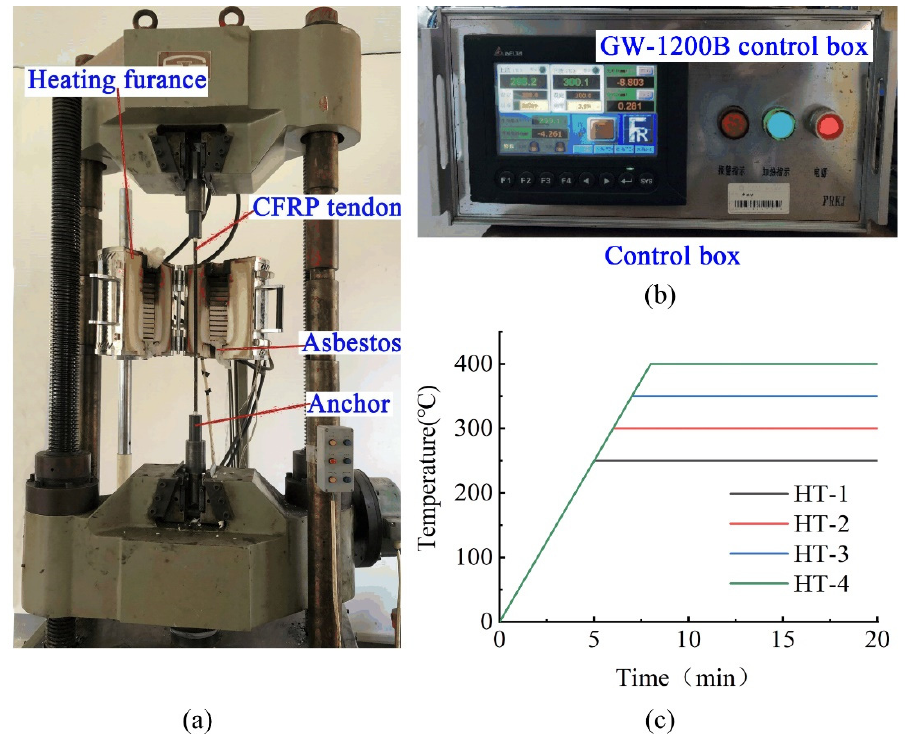
Figure 2. Fabrication process of the anchoring system.